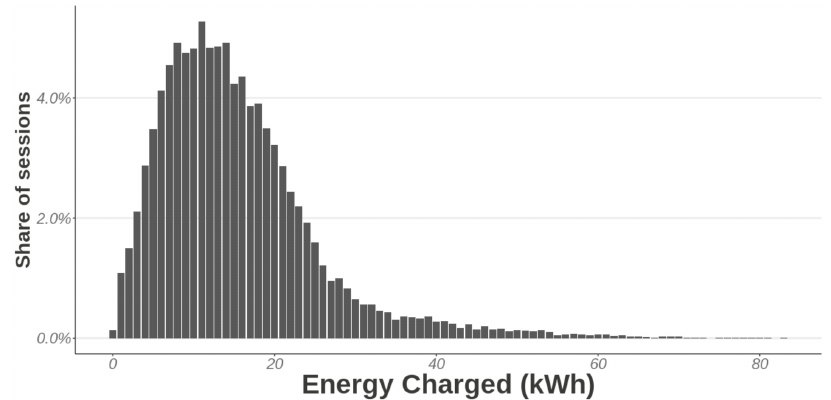
Figure 1. Distribution of energy charged at fast charging stations.